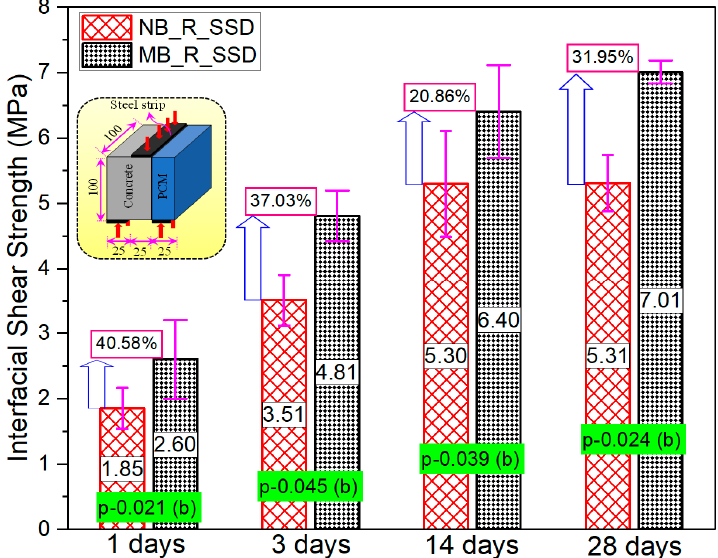
Figure 14. Interfacial strength of normal PCM and modified 5% silica PCM specimen at early ages.